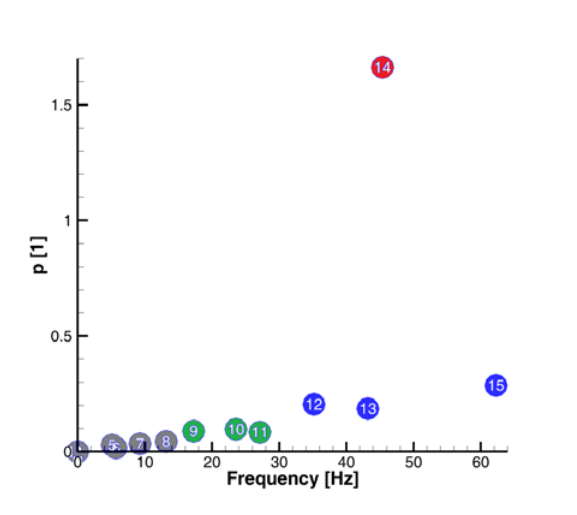
Fig. 5. OPD spectrum